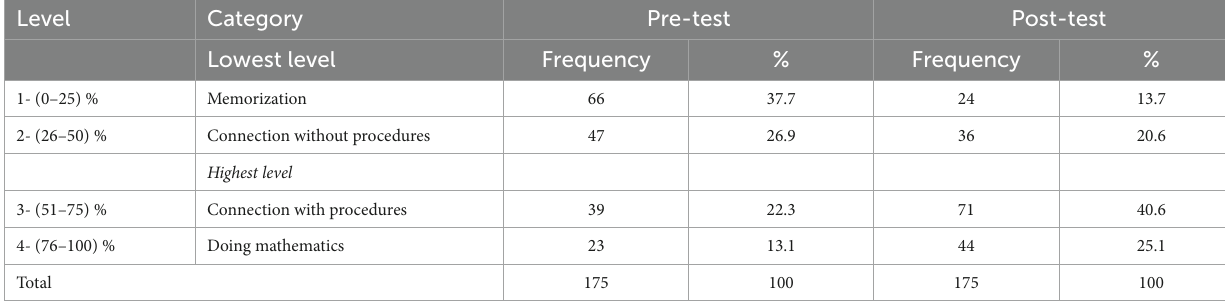
TABLE 2 Academic evaluations of students based on Stein’s levels of cognitive